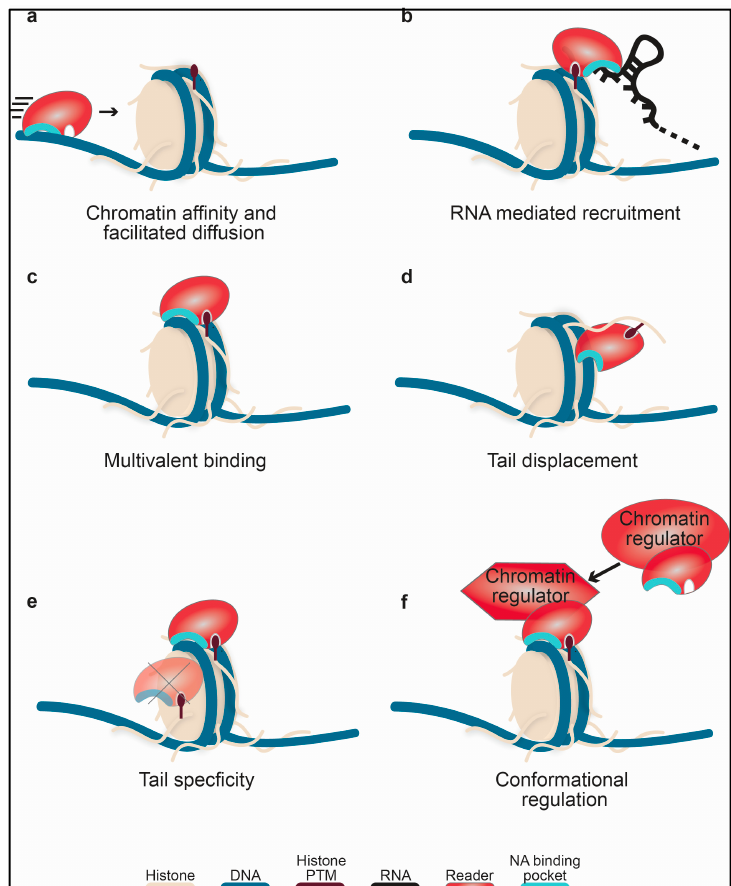
Figure 1. Models of the functional consequence of nucleic acid binding. Shown for each is a cartoon representation of a mono-nucleosome (DNA dark blue, histones wheat), containing a histone post-translational modification (PTM) (crimson oval), and a reader domain (red) containing a PTM binding pocket and a DNA binding surface (cyan). Representations of nucleic acid binding contributing to ( a ) chromatin affinity and/or facilitated diffusion, ( b ) RNA mediated recruitment, ( c ) multivalent nucleosome binding, ( d ) histone tail displacement from DNA, ( e ) histone tail specificity through positioning, or ( f ) modulation of regulator activity through conformational change.